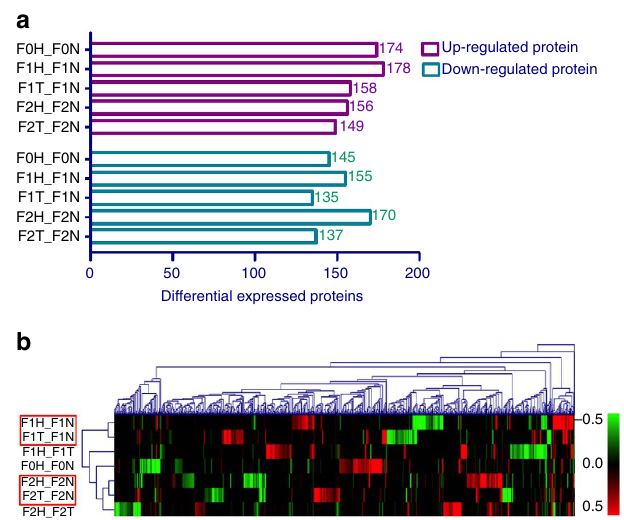
Figure 2 | Hypoxia induces differentially expressed proteins (DEPs) in testis of the F0, F1 and F2 generations. ( a ) DEP statistics. x axis represents the number of differentially expressed proteins. y axis represents the names of comparable groups in different generations. ( b ) Hierarchical clustering heat map (Dendrogram calculated in Euclidean distance and represented by average linkage method). The colour scale represents the fold change in the log 2 ratio. Red and green bars indicate upregulation and downregulation, respectively. A 1.1-fold change was set as the threshold, and P o 0.05 was considered to identify significant differences in protein expression ( n ¼ with impaired sperm function caused by hypoxia, we analysed the F0 groups, we obtained 37.8 M and 34.5 M quality trimmed reads, which translates to 5.6 Gb and 5.2 Gb of total clean bases for the F0N and F0H groups, respectively. For the F2 group, 20.4 M, 18.8 M and 22.2 M quality trimmed reads yielded 3.1 Gb, 2.8 Gb and 3.3 Gb of total clean bases for the F2N, F2H and F2T groups, respectively. Among the 1,1652 expressed genes, 2,411 were differentially expressed ( P o 0.05) and assigned gene ontology terms. Differentially expressed genes in each group were classified into the categories of cellular component, molecular function and biological process. The distribution pattern was extremely similar